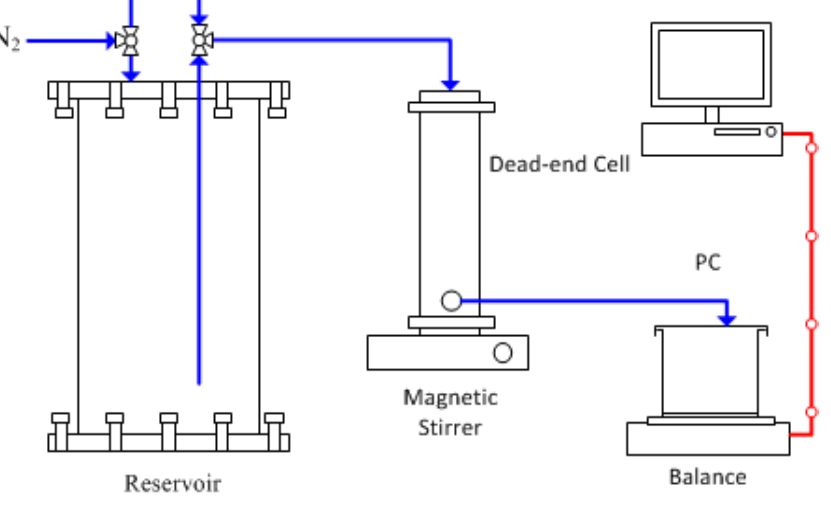
Figure 8. Schematic diagram of bench-scale flux test